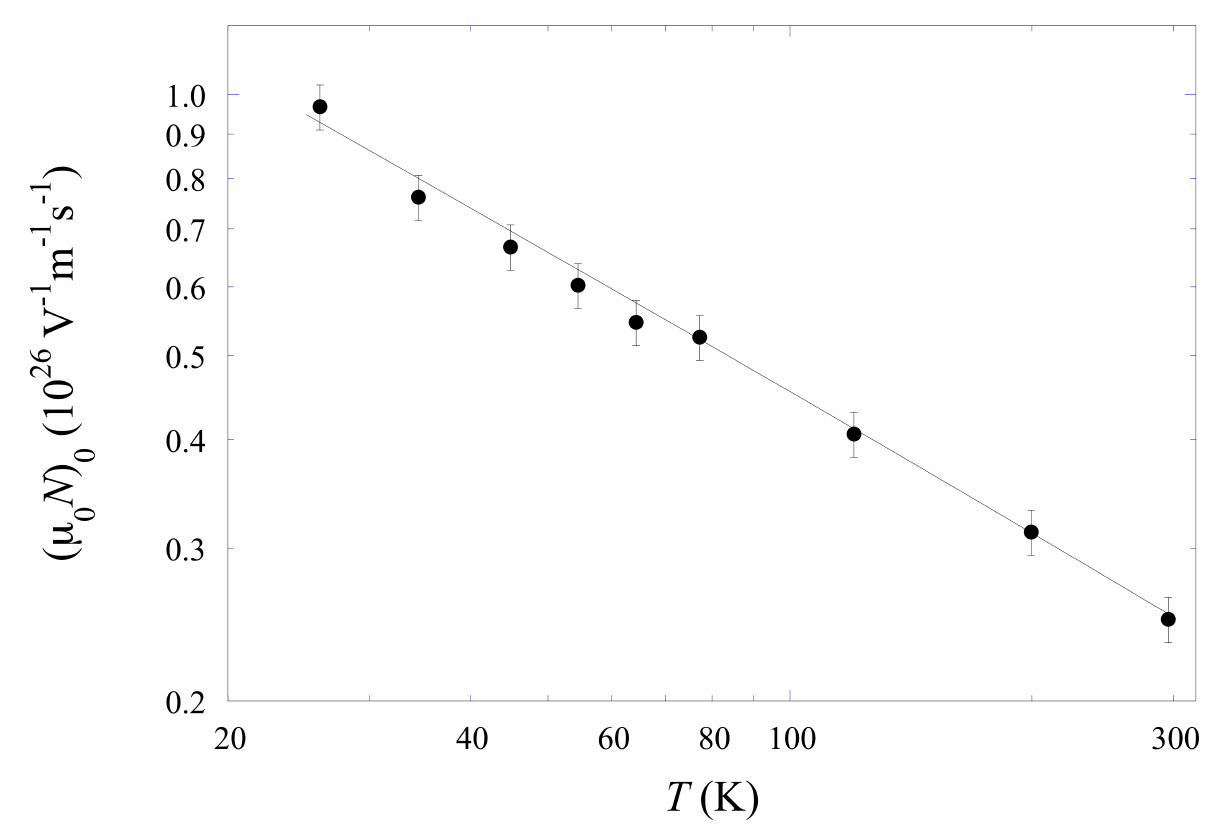
Figure 5. ( µ 0 N ) vs. T . The solid line is the prediction of the heuristic model which, for N 0 classical kinetic prediction [26]. Data and theory are well fitted to the inverse power law T − 0.536 close to the T − 1/2 behavior of a gas of hard-sphere scatterers.